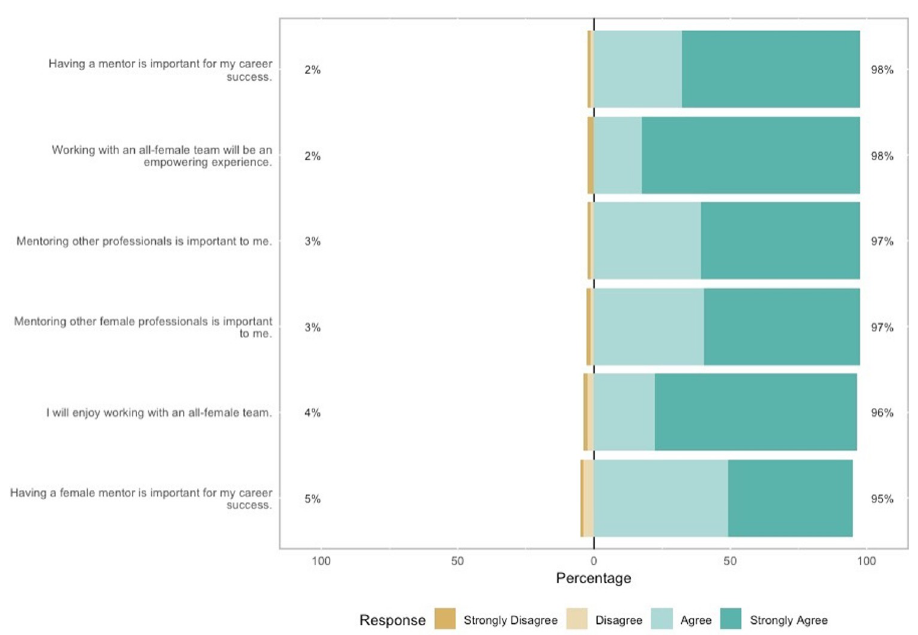
Fig 4. Opinions on mentorship before the mission.